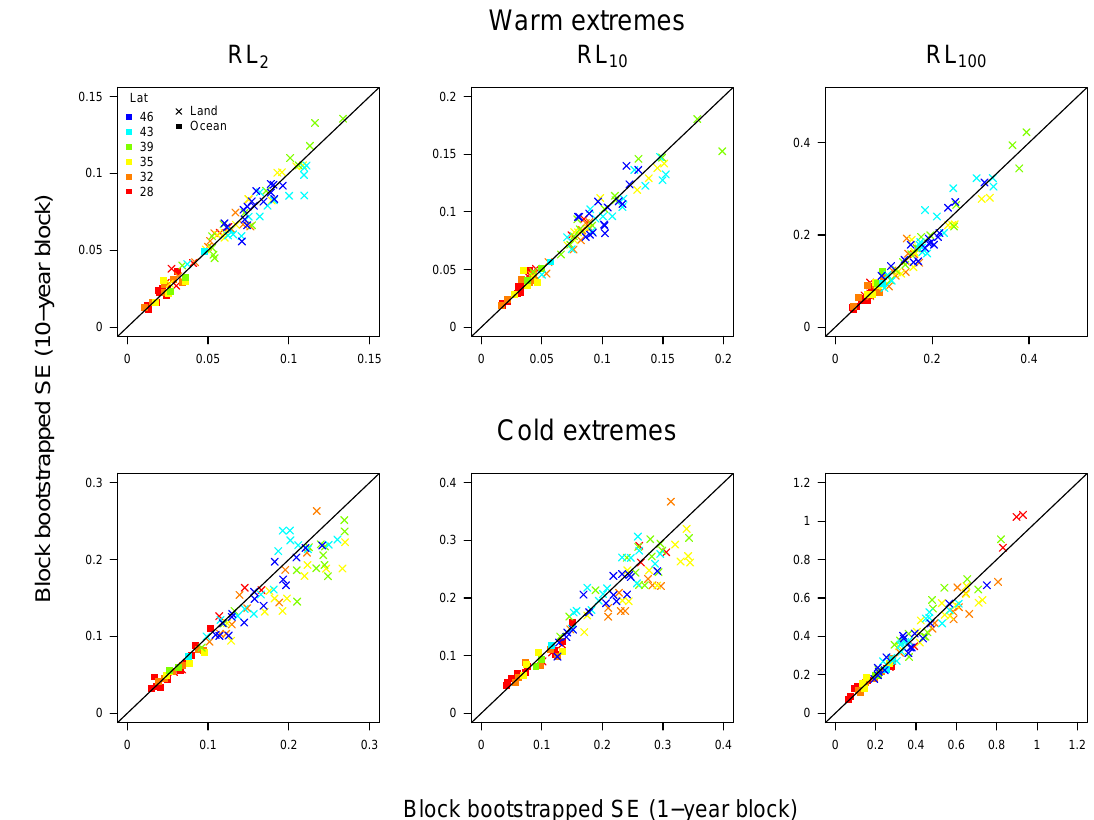
Figure D2. Assessment of estimation uncertainty to return levels using different block sizes for block bootstrap. The scatterplot shows block bootstrapped standard errors by resampling years ( x axis) and decades ( y axis) of 2-year (left), 10-year, and 100-year (right) return